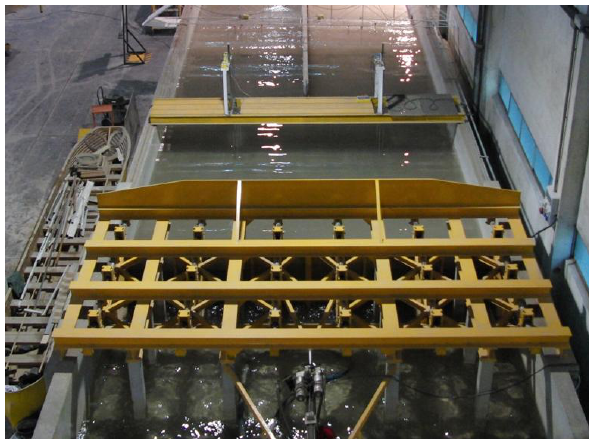
Fig. 2. Details of the wave maker with the double structure to pre- vent the appearance of vibrations.